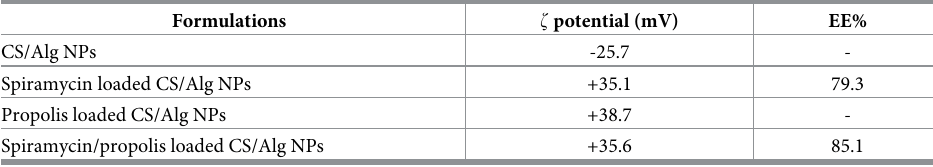
Table 1. Zeta-potential ( z ) and entrapment efficiency (EE) of the prepared nano